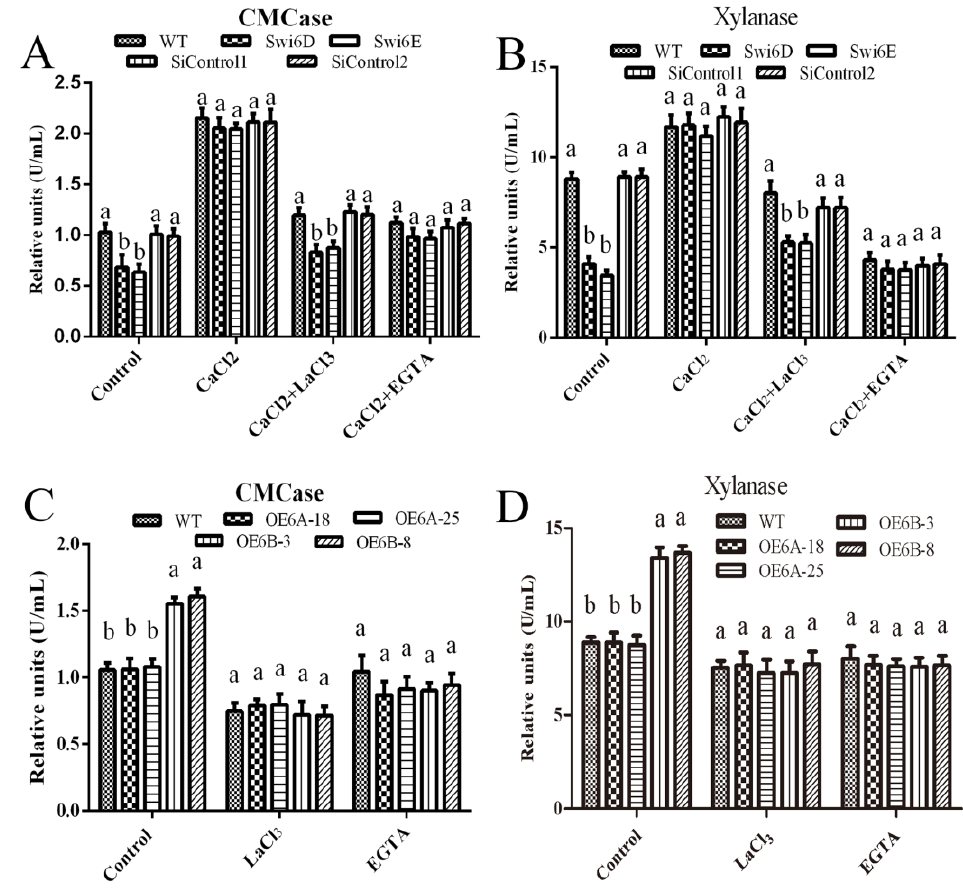
Figure 4. Intracellular Ca 2+ content is involved in the regulation of cellulase and xylanase activity by GlSwi6. G. lucidum cultured in CYM liquid medium for 5 days were transferred to MCM medium using cellulose as the sole carbon source and then treated with 5 mM CaCl 2 , LaCl 3 , or EGTA, respec- tively for 24 h. The CMCase activities in GlSwi6-silenced strains ( A , C ) and GlSwi6 overexpression strains ( B , D ). The values are the mean ± SE ( n = 3). Different letters indicate significant differences between the strains ( p < 0.05, Tukey′s test).